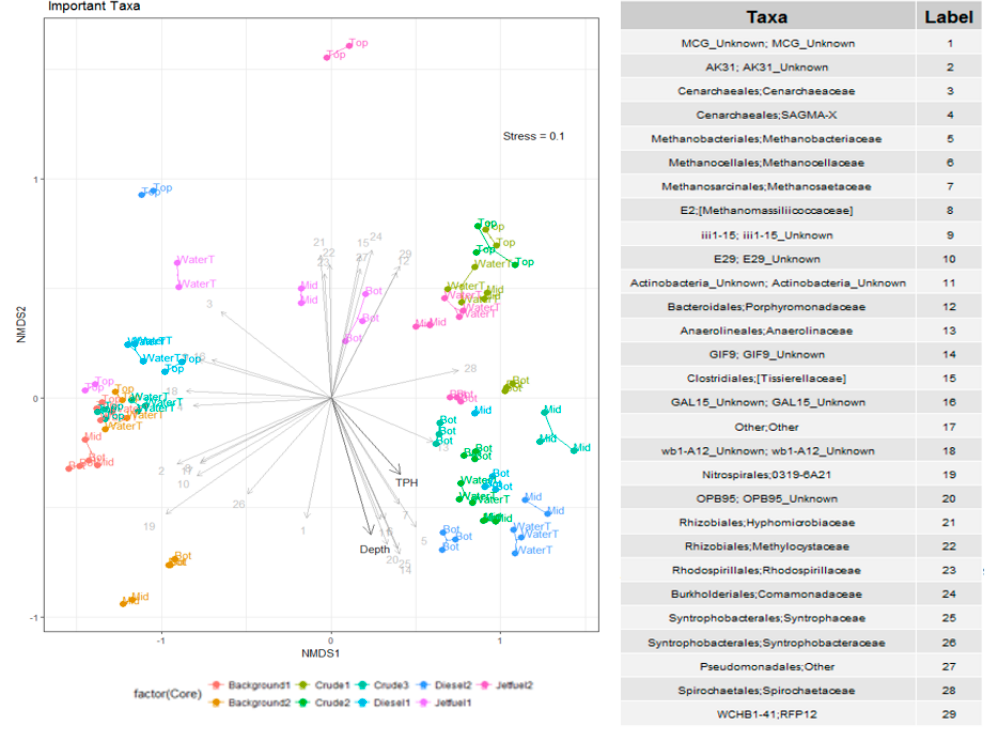
Figure 2. Significant environmental parameters and abundant taxa. Non-metric multidimensional scaling (NMDS) plot based on the Bray Curtis dissimilarity. Vectors show the most abundant taxa present (>4% relative abundance) and environmental parameters determined to be significant.